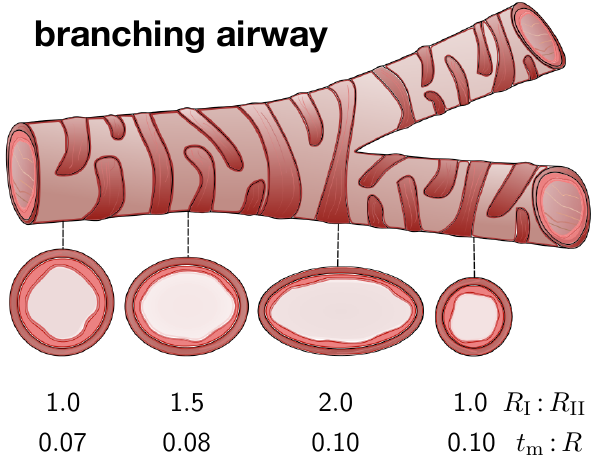
varying cross sections along the bronchus